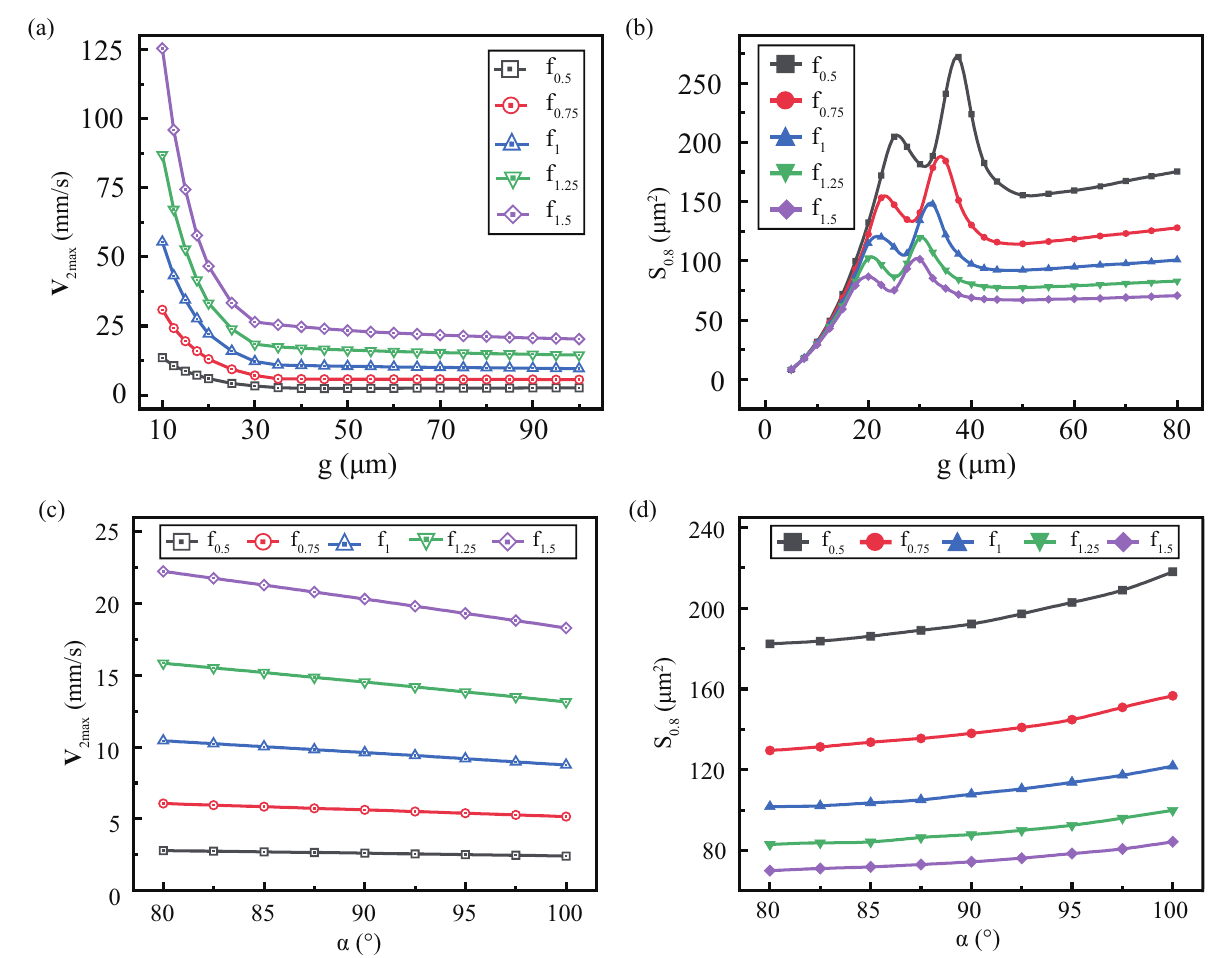
Figure 9. Effect of side profile parameters on streaming under viscous frequency. There are the effect of the gap on the maximum streaming velocity ( a ) and effective area ( b ), as well as the effect of the sidewall angle on the maximum streaming velocity ( c ) and effective area ( d